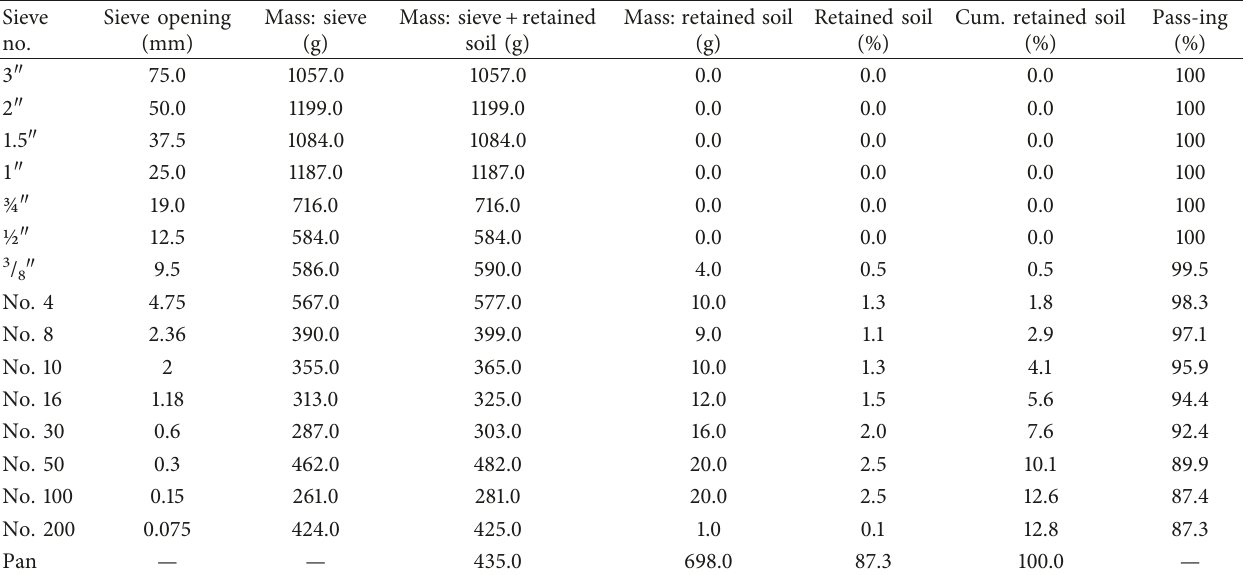
Table 3: Sieve analysis test result.